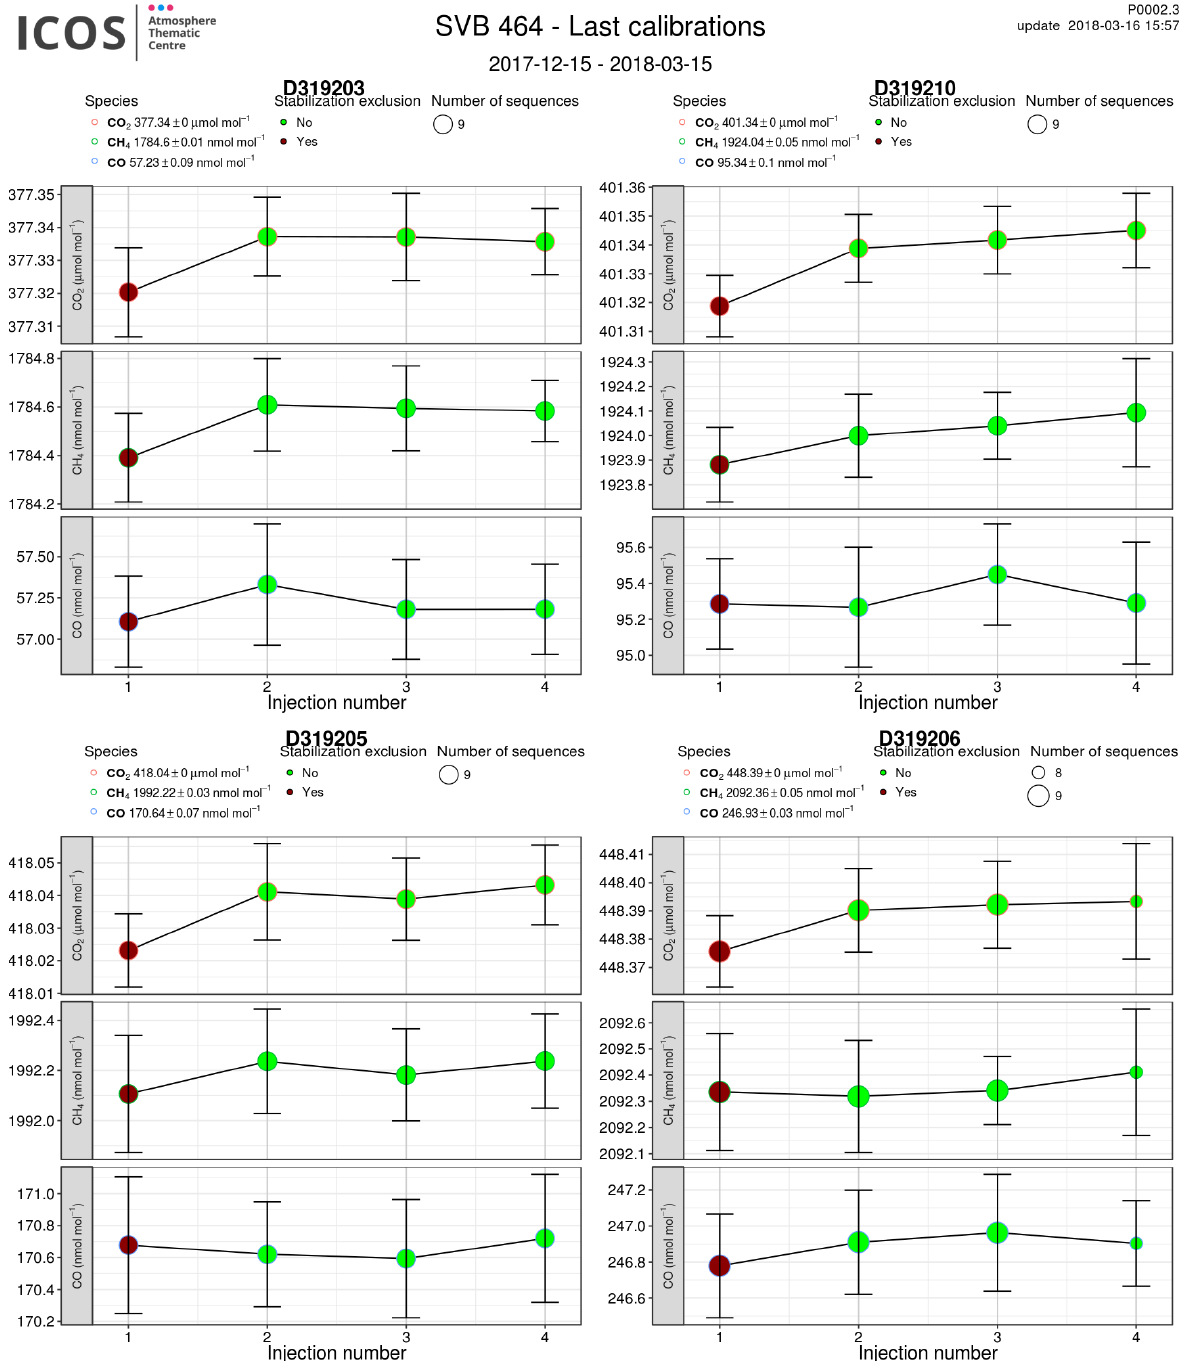
Figure 7. Average of each cycle injection for the last calibrations over 3 months at Svartberget station (SVB) for instrument 464. Green dots are data used for the calibration correction, and red is rejected for stabilization. The number of calibrations is shown on the top right. Assigned values are on the top left. Cylinder number (D******) is shown at the top of each